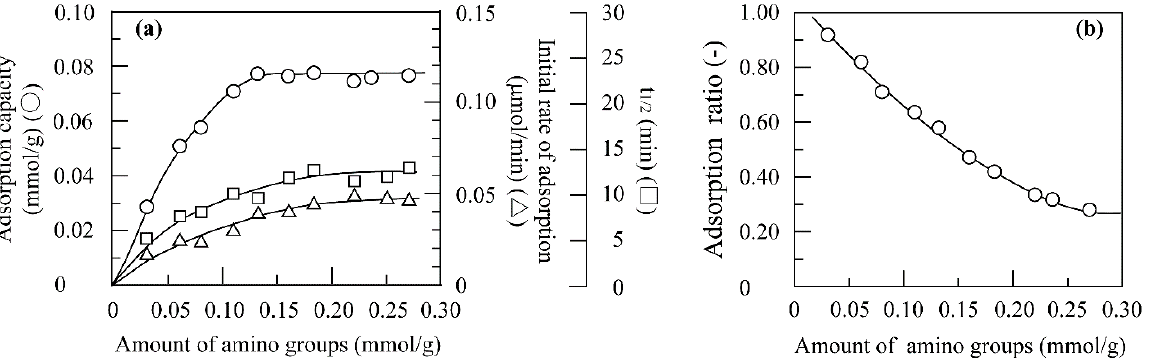
Figure 7. Changes in ( a ) the adsorption capacity ( ( (cid:3) ) and ( b ) the adsorption ratio with the amount of amino groups for AEAPTES silica beads in a 0.20 mM K 2 Cr 2 O 7 solution at pH 3.0 and 30 ◦ C.